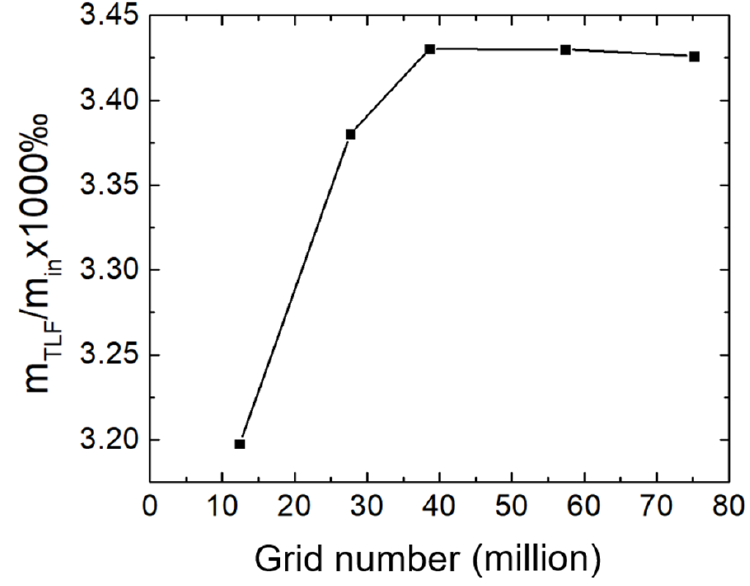
Figure 2. Grid-independence verification.